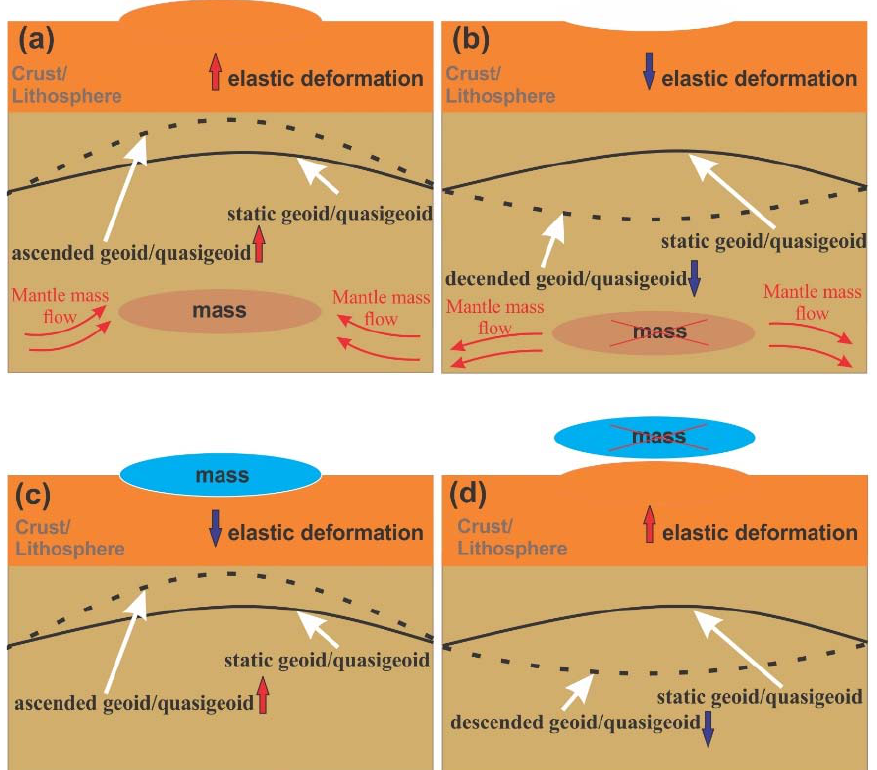
Figure 1. The relation between temporal mass variations within the Earth’s system (TMVES), geoid/quasigeoid height changes, and the elastic deformation of the Earth’s surface in the up component. ( a ) the mass under the geoid/quasigeoid surface increases, ( b ) the mass under the geoid/quasigeoid surface decreases, ( c ) the mass on the Earth’s surface increases, and ( d ) the mass on the Earth’s surface decreases. The orthometric/normal heights corrected for their dynamics H ( t )/ H * ( t ) can be de- fined at arbitrary time t as a sum of the orthometric/normal height H ( t 0 )/ H * ( t 0 ) at the ref- erence epoch t 0 , and temporal variations of orthometric/normal heights ∆ H ( t )/ ∆ H * ( t ) at t . The mathematical formulation of the proposed approach for the determination